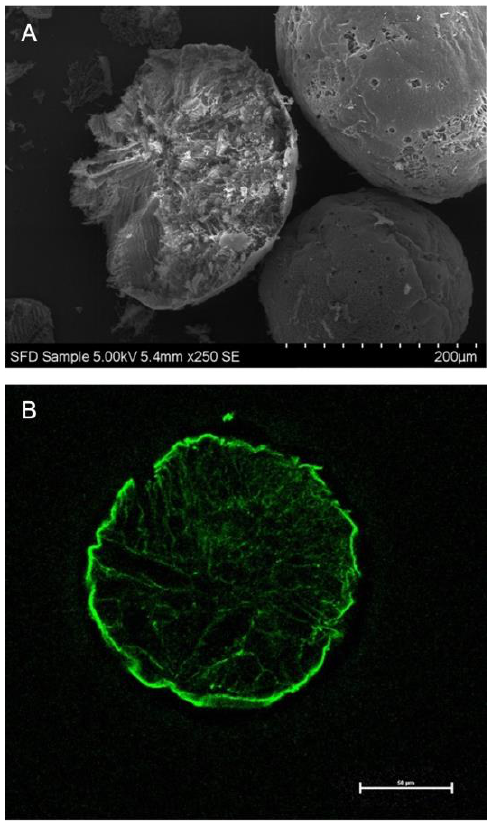
Figure 2. Cross-sections of insulin loaded SFD particles without any penetration enhancer imaged by SEM ( A ) or confocal laser scanning microscopy ( B ) containing FITC-labeled insulin.